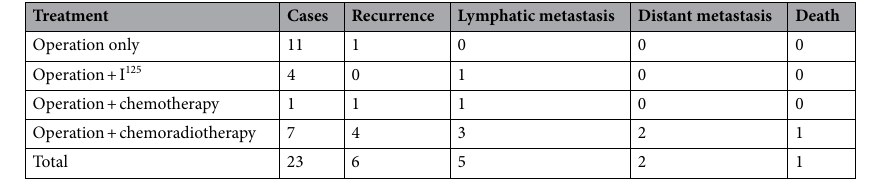
Table 2. Outcomes of 23 patients with SCSG treated by different therapies. SCSG, secretory carcinoma of salivary gland.